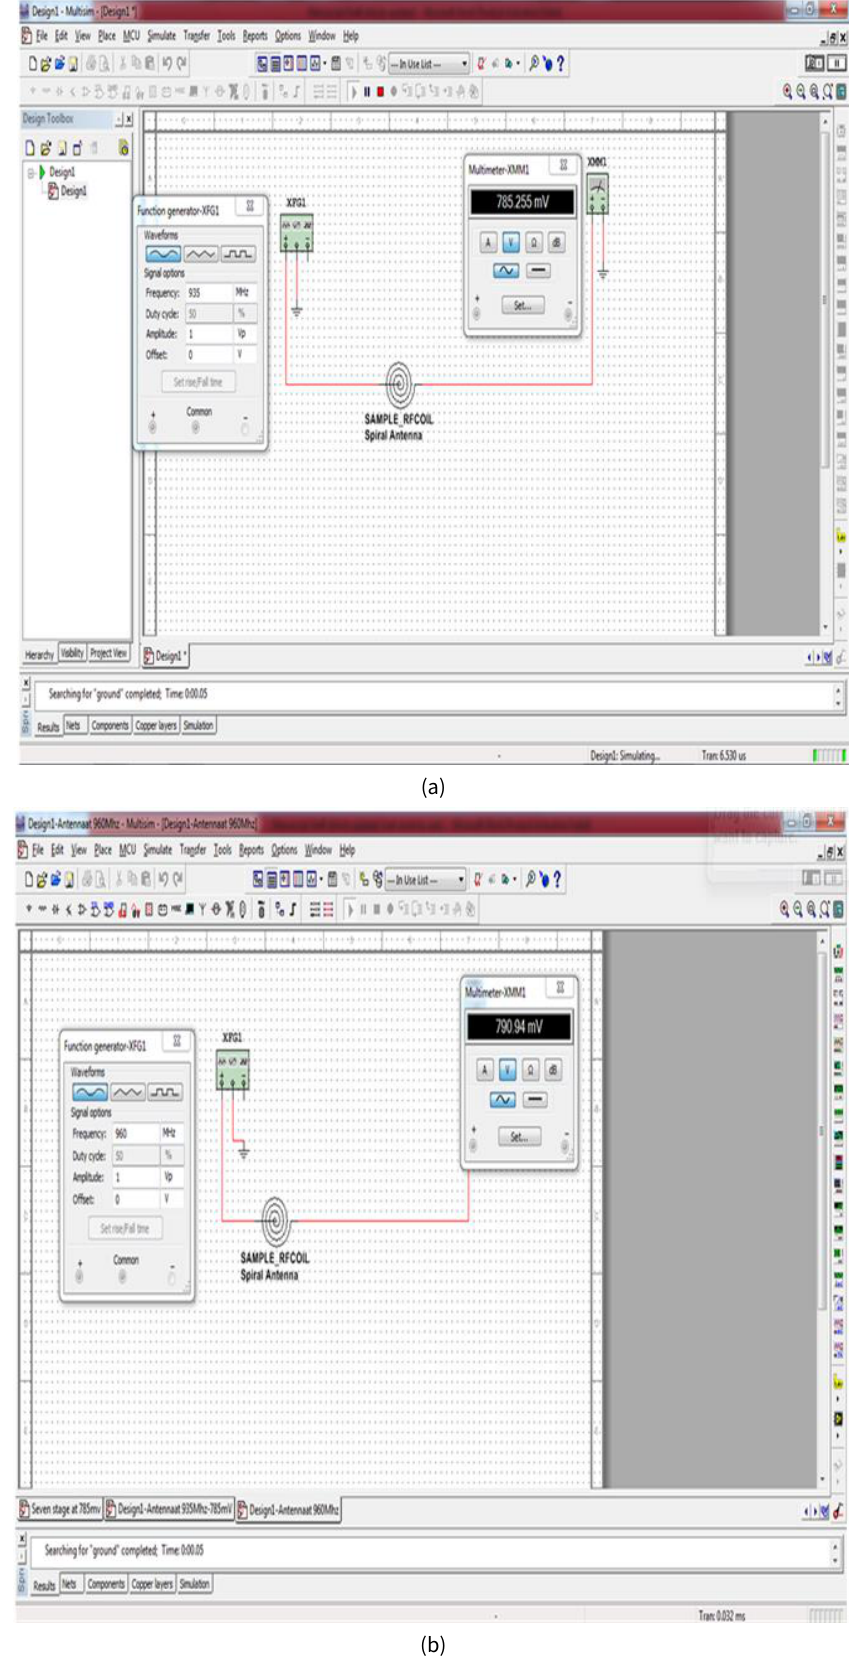
Figure 2. (a) The Antenna simulation using 935MHz (b) The Antenna simulation using 960